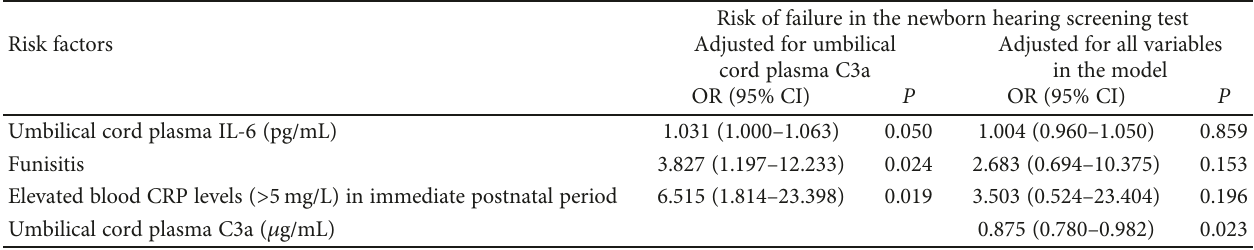
Table 4: Risk factors associated with newborn hearing screening test failure according to logistic regression